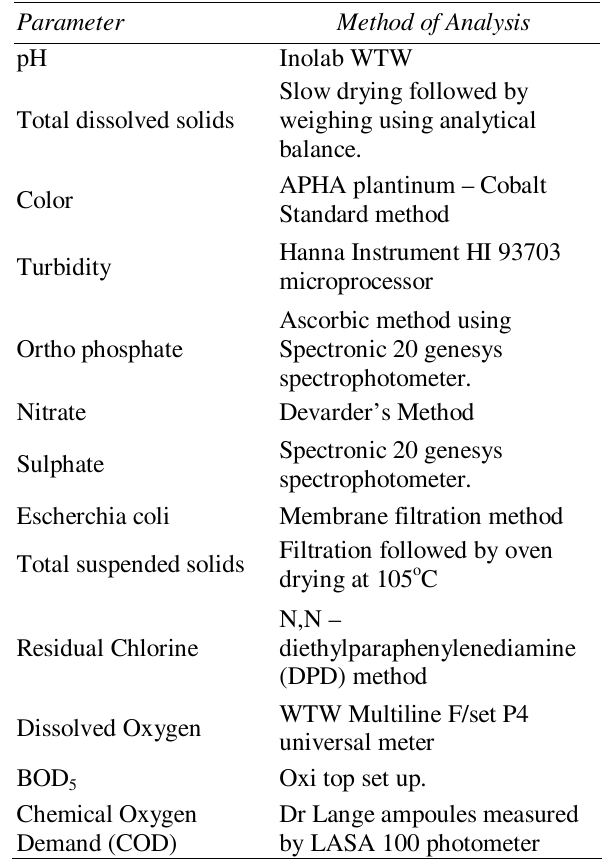
Table 1(b): ANOVA Analysis on difference of data from the two approaches Source of